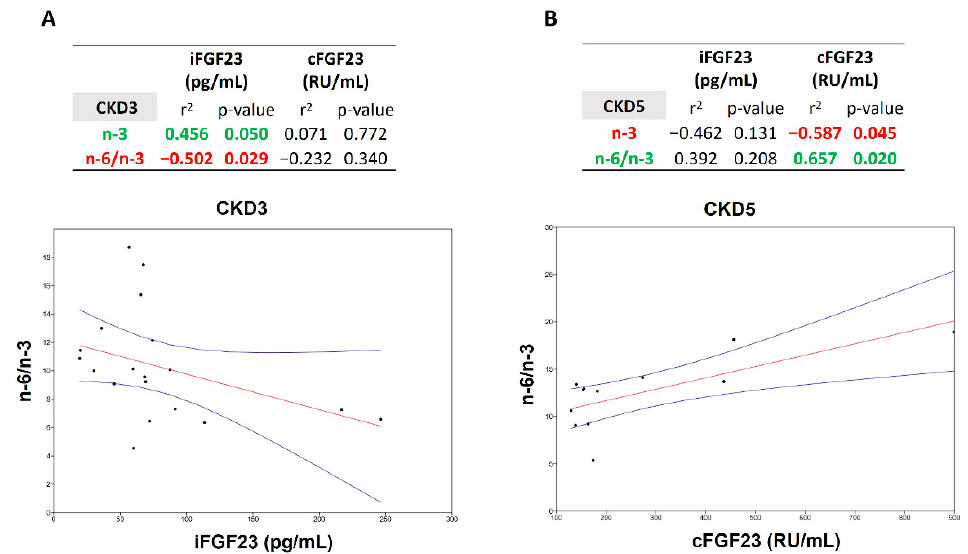
Figure 3. Correlation between n-6/n-3 and n-3 and i/cFGF23 among CKD stage 3 ( A ) and 5 ( B ). Significant positive correlation in green and negative in red. “ − ” indicates a negative correlation. Two-tailed Spearman bivariate analysis. n = 19 in CKD3, n = 12 in